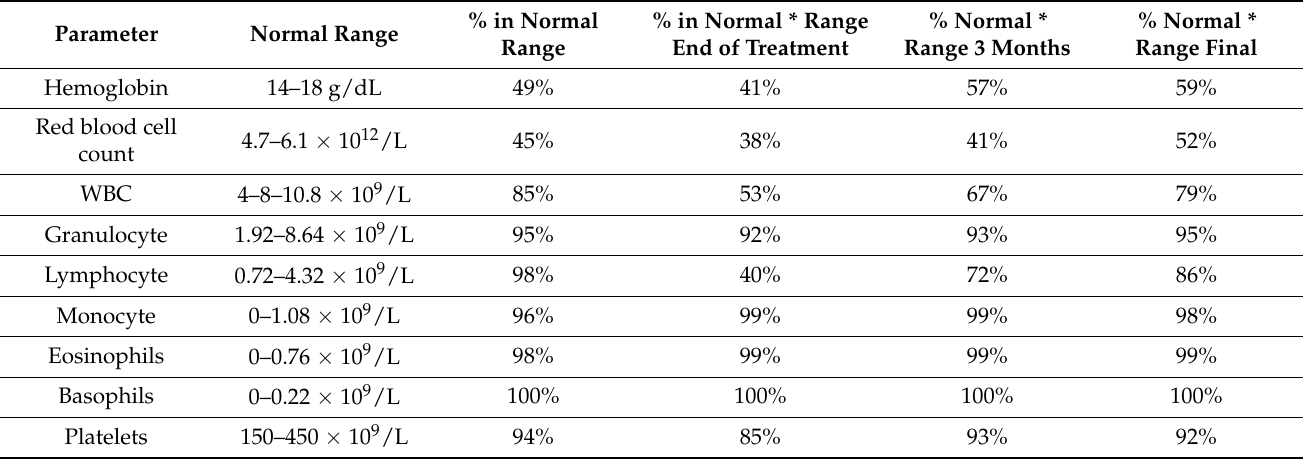
Table 2. Normal blood count levels in our laboratory and changes with